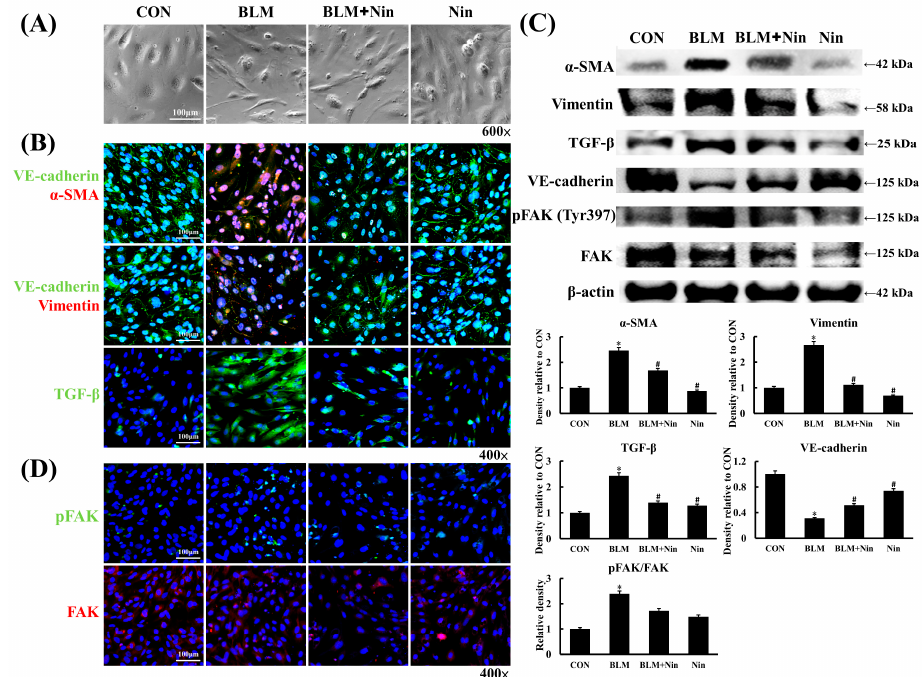
Figure 4. Nintedanib inhibits in vitro BLM-induced EndoMT. ( A ) Representative phase-contrast images of HPMECs treated with BLM or nintedanib alone or in combination. ( B ) Representative IF staining images of α -SMA, VE-cadherin, vimentin, and TGF- β in HPMECs treated with BLM or nintedanib alone or in combination. Scale bars, 100 µm. Green, VE-cadherin and TGF- β ; red, α -SMA and vimentin; blue, DAPI. ( C ) Western blot and semi-quantitative analysis of protein expression in HPMECs treated with BLM or nintedanib alone or in combination. Western blot was performed using the indicated antibodies. n = 3–5 in each group. Data are presented as mean ± standard error of mean. * p < 0.05 vs. control, and # p < 0.05 vs. BLM (two-tailed Student’s t-test). ( D ) Representative IF staining images of FAK and pFAK in HPMECs treated with BLM or nintedanib alone or in combination. Scale bars, 100 µm. Green, pFAK; red, FAK; blue, DAPI. α -SMA, alpha smooth muscle actin; BLM, bleomycin; CON, control; EndoMT, endothelial mesenchymal transition; FAK, focal adhesion kinase; HPMEC, human pulmonary microvascular endothelial cell; IF, immunofluorescence; IHC, immunohistochemistry; Nin, nintedanib; pFAK, phosphorylated focal adhesion kinase; TGF- β , transforming growth factor beta; VE-cadherin, vascular endothelial cadherin.